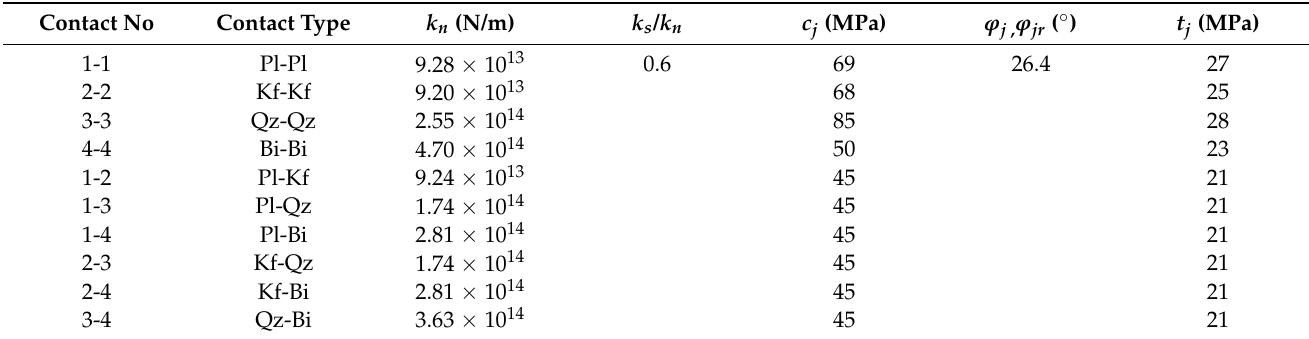
Table 3. Corrected microscopic